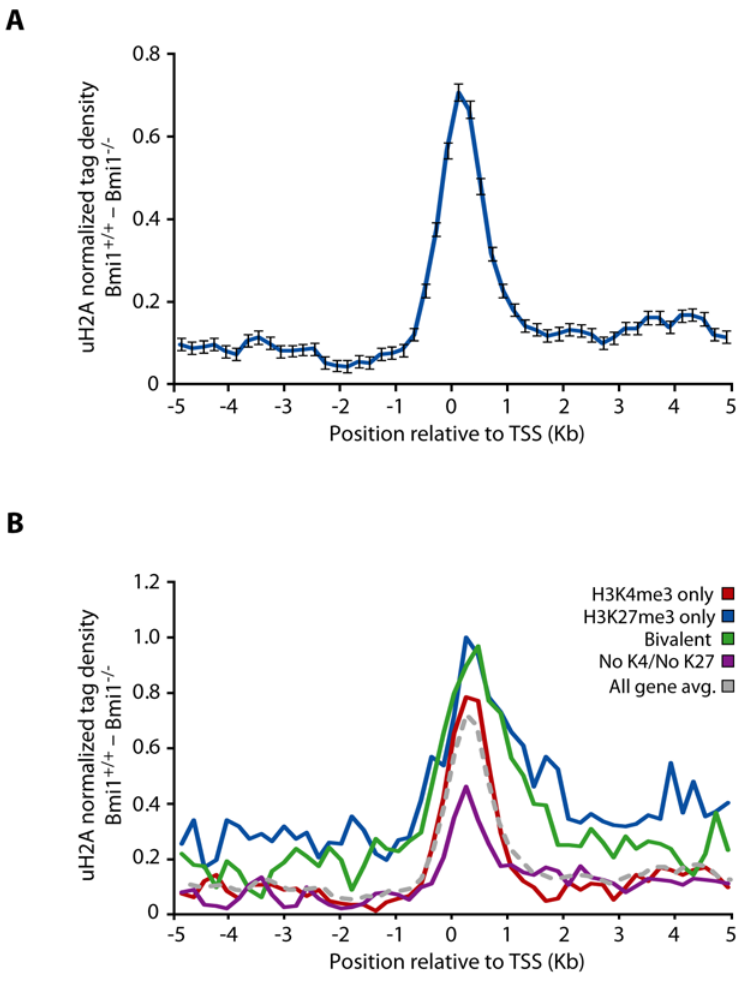
Figure 1. Bmi1-dependent promoter uH2A enrichment correlates with promoter H3K27me3 enrichment. (A) Profiles of per base pair Bmi1-dependent uH2A enrichment across the TSS of well annotated genes. Error bars represent s.e.m. of per base pair average for all genes analyzed ( n = 15867). (B) Well-annotated genes were grouped by epigenetic modification state and the average normalized uH2A tag density was determined for each group. No K4/No K27 ( n =4690), purple; both H3K4me3 and H3K27me3 (Bivalent) ( n =1377), green; H3K27me3 only ( n =888), blue; H3K4me3 only ( n =8912), red; all genes ( n =15867), grey.